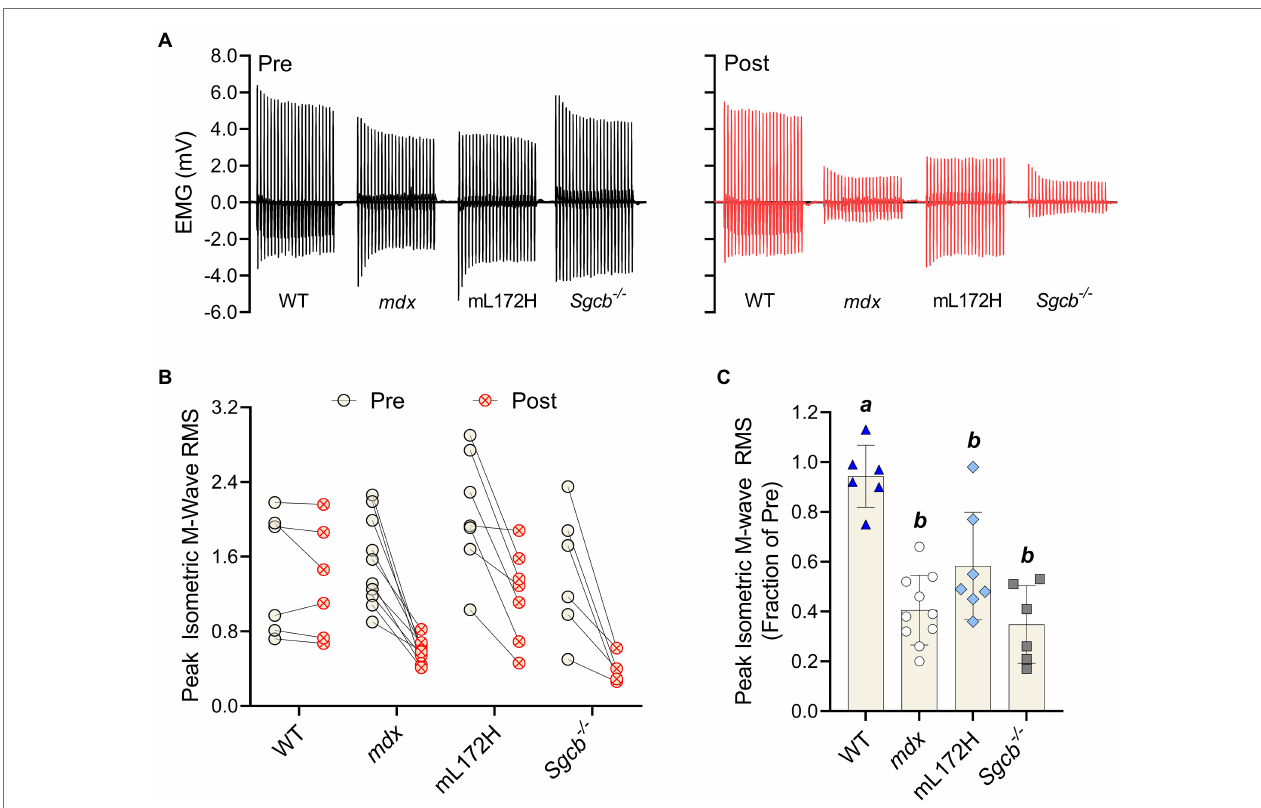
FIGURE 4 | Dystrophin content does not prevent loss of plasmalemmal excitability following a bout of ECC contractions. (A) Representative peak isometric EMG tracings pre- and post-ECC contractions. (B) Peak isometric M-wave RMS of each individual mouse pre- and post-ECC contractions; solid line between Pre and Post indicates same mouse. (C) Peak isometric M-wave RMS expressed as a fractional change pre- to post-ECC contractions. Groups with the same letter are not significantly different from each. Significance was set at p < 0.05. Bars are mean ±